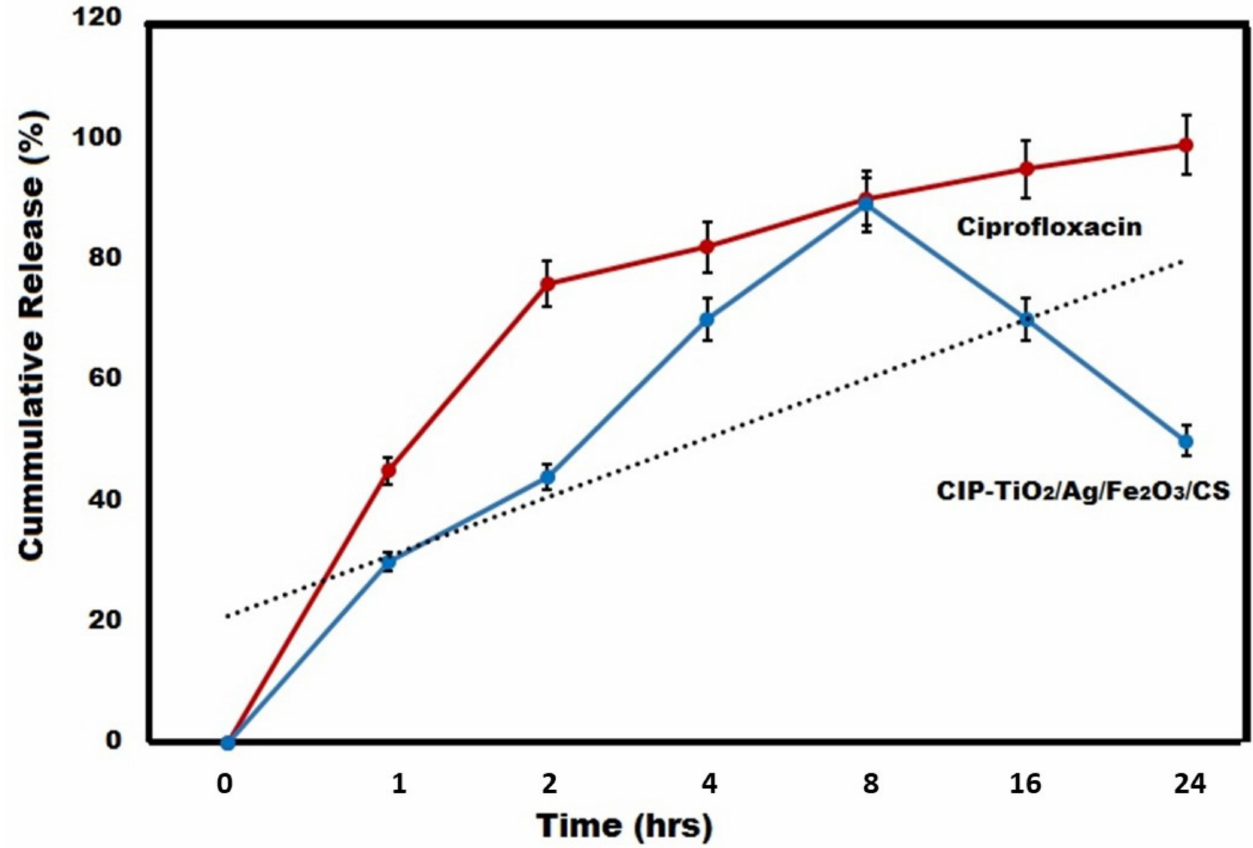
Figure 13. In vivo (rabbit skin membrane) CIP release profile from CIP-Ag/TiO 2 /Fe 2 O 3 /CS nanofor- mulation (NDDS) used at MIC. CIP was taken as control at